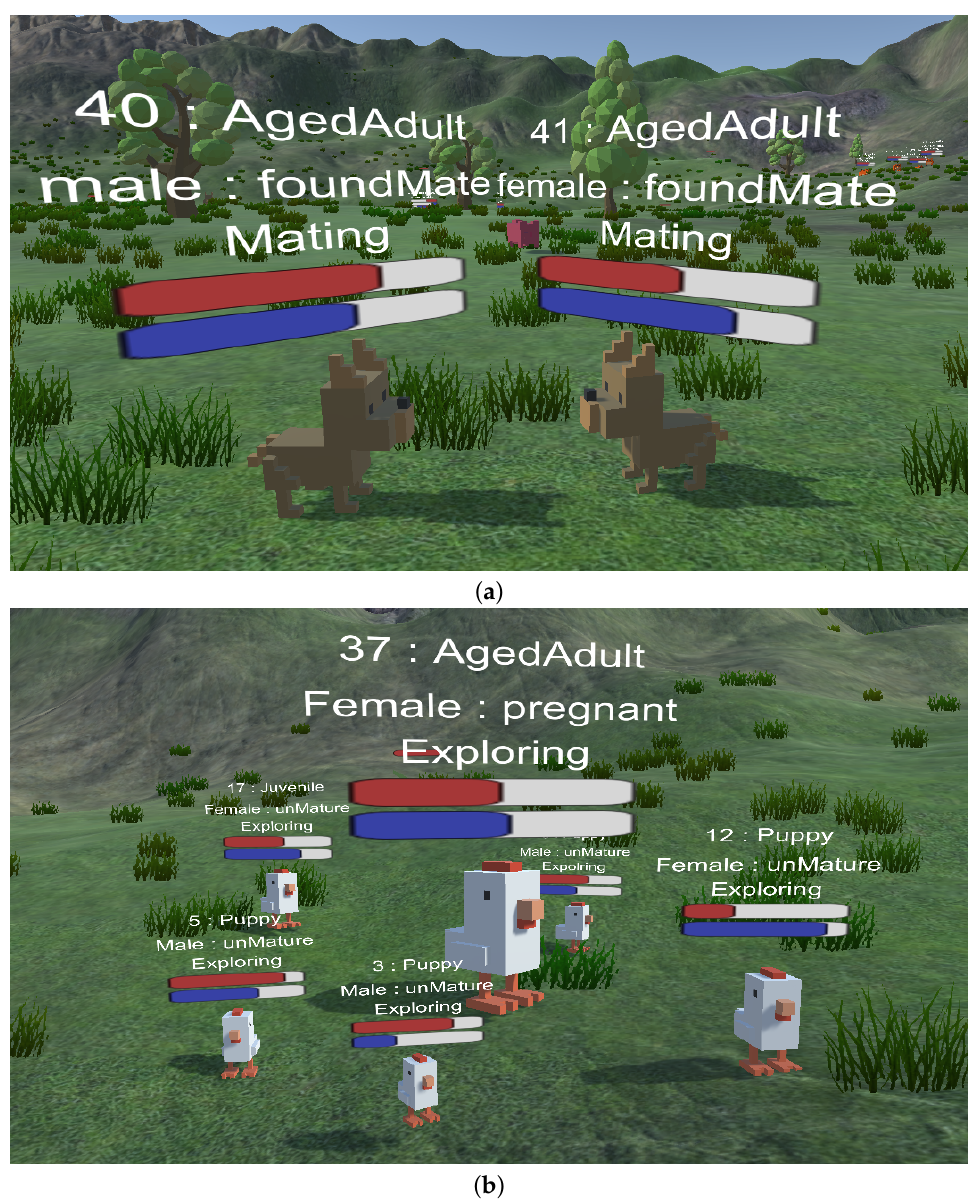
Figure 9. The most important event in any organism’s life is the reproduction biological (mating) process for population preservation, in which an organism gives life to young ones (offspring) similar to itself. ( a ) All species rely on the selection and attraction of a compatible partner to survive. ( b ) Reproduction ensures the species’ survival from generation to